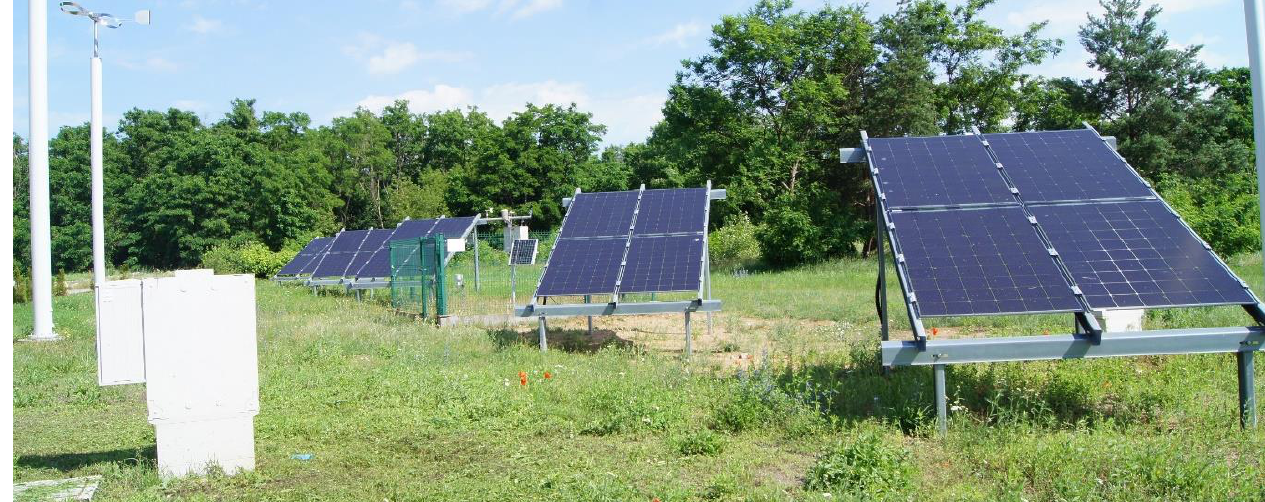
Figure 7. Setting up 5 × 4 panels on the ground in Bydgoszcz.